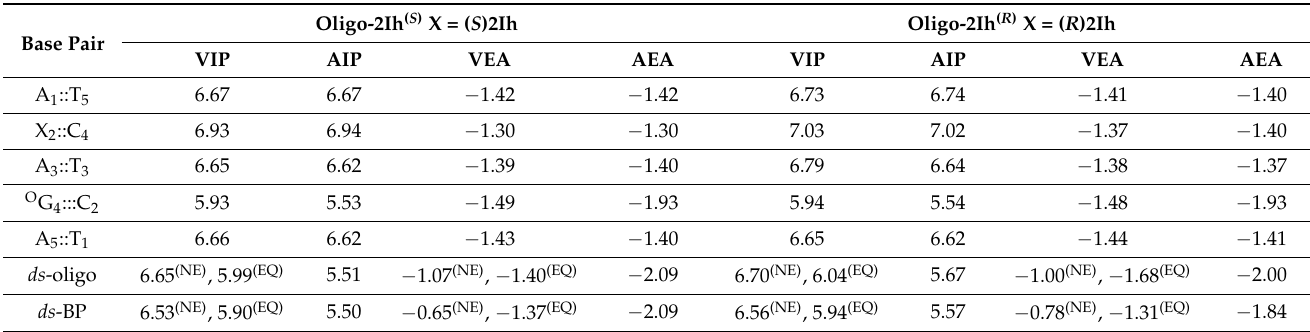
Table 2. Electronic properties of oligo-2Ih ( R ) and oligo-2Ih ( S ) as well as isolated base pairs (BP): Vertical (VIP), Adiabatic Ionization Potential (AIP), Vertical (VEA), and Adiabatic (AEA) Electron Affinity are calculated at the M062x/6-31++G** level of theory in the aqueous phase. NE—non- equilibrated solvent-solute interaction; NE—equilibrated solvent-solute interaction. All data are given in